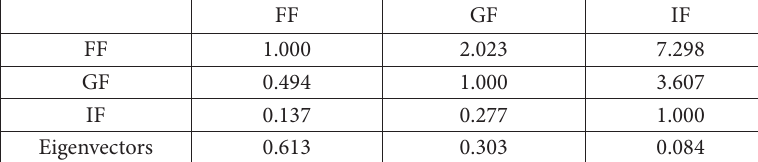
Table 2. The comparisons and eigenvectors (weights) of 3 groups